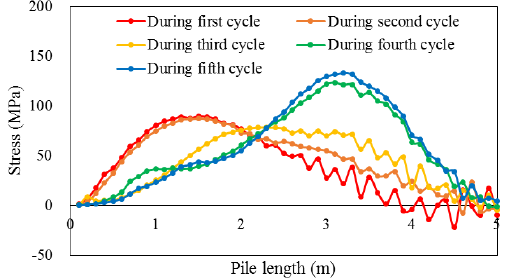
Figure 26. Variation in stress acting on Pile-1 during Stage 2 of each construction cycle at cover depth of 1.5 m.